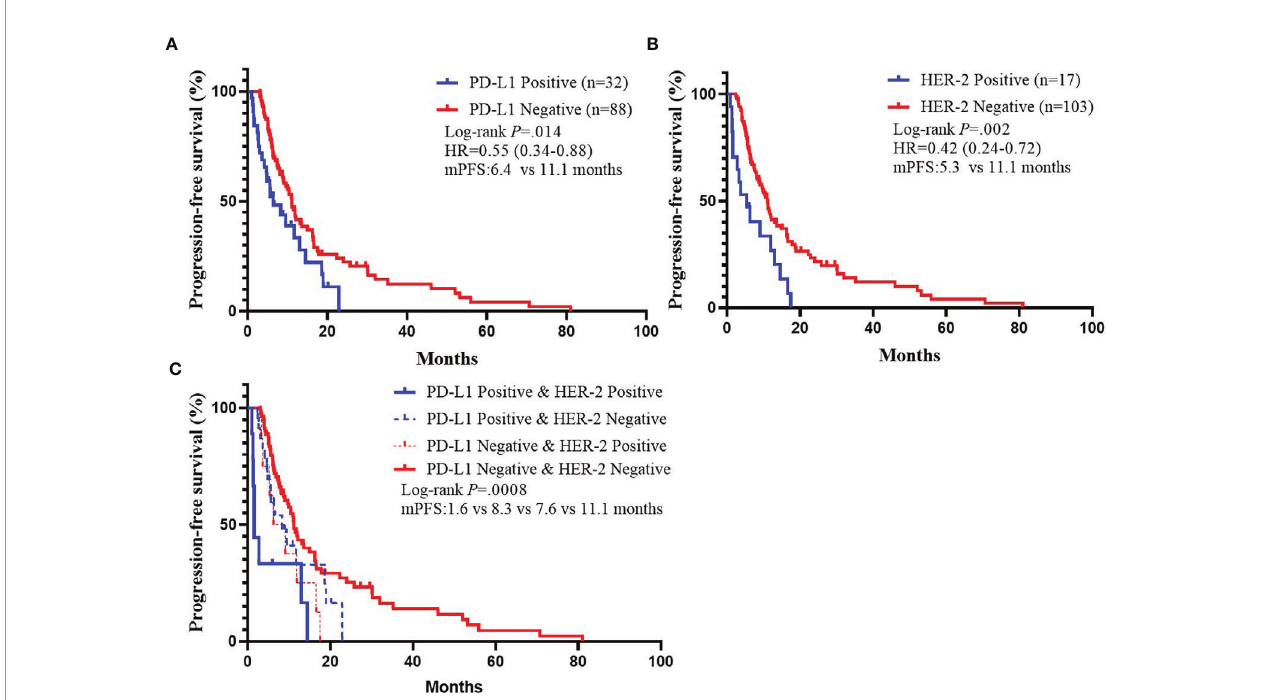
FIGURE 2 | Kaplan – Meier Estimates of Progression-Free Survival by PD-L1 Status or HER-2 status. (A) Kaplan – Meier survival curves of PFS by PD-L1 status. (B) Kaplan – Meier survival curves of PFS by HER-2 status. (C) Kaplan – Meier survival curves of PFS by PD-L1 and HER-2 status.